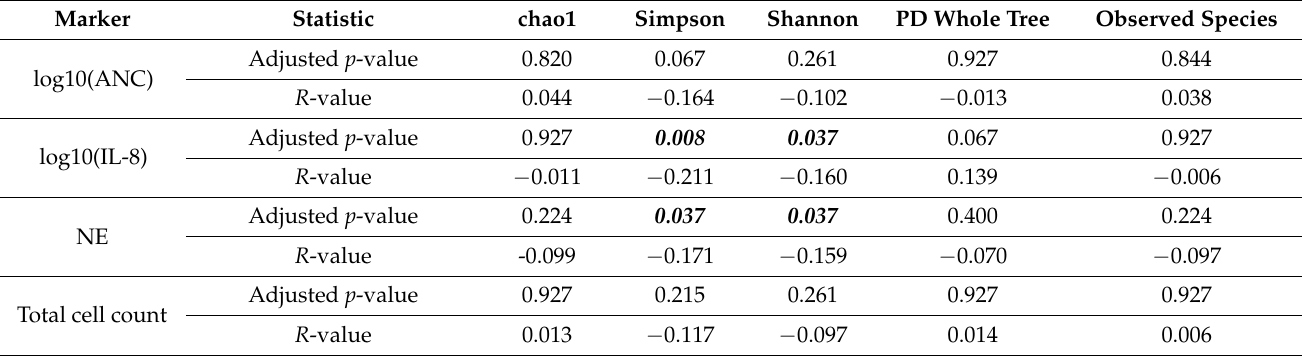
Table 2. Correlations between inflammation and measures of alpha diversity.